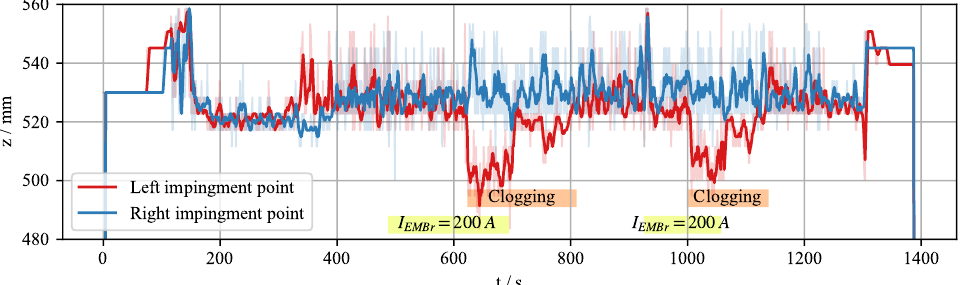
Figure 8. Controller validation experiment. The flow reaches a stable state by t = 200 s. The same scenario is repeated twice during the same experiment. First, the EMBr current is set to I EMBr = 200 A at t ≈ 500 s and t ≈ 900